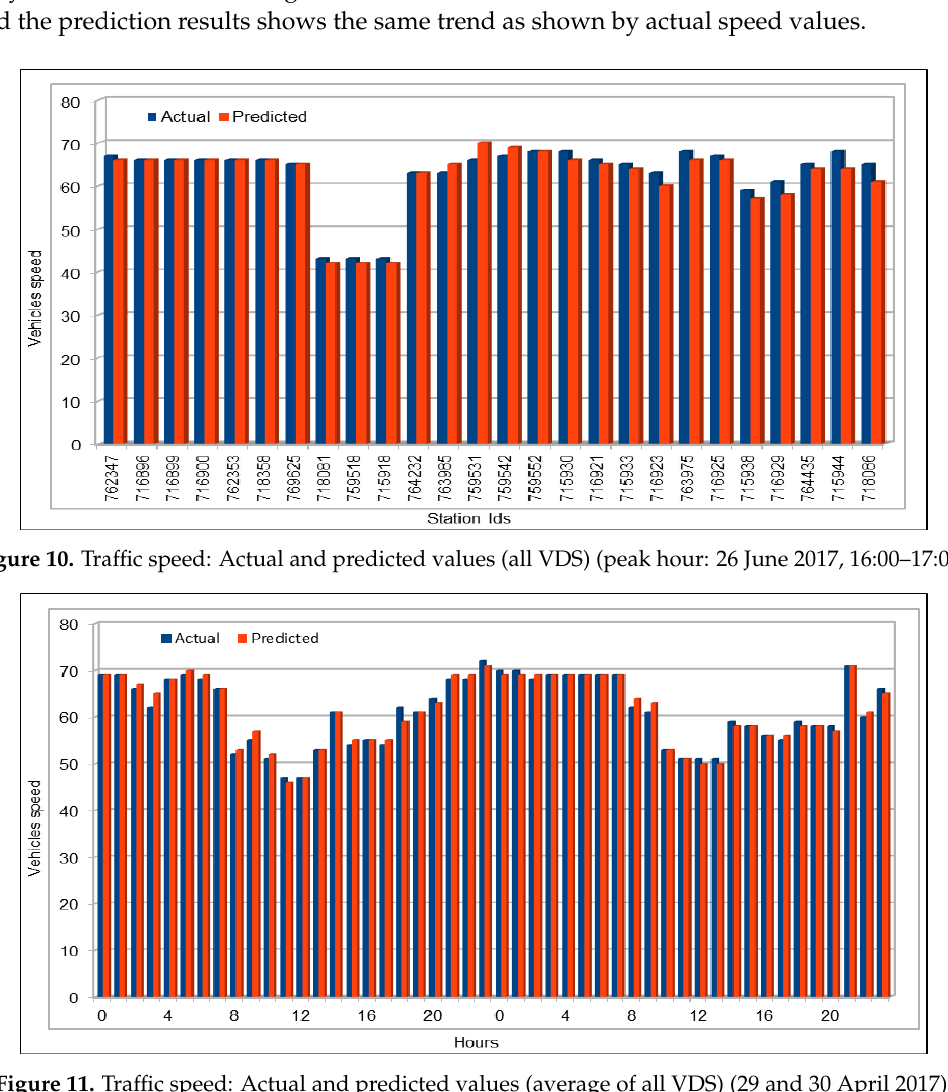
Figure 11. Traffic speed: Actual and predicted values (average of all VDS) (29 and 30 April 2017). Table 4. Traffic speed: Deep model